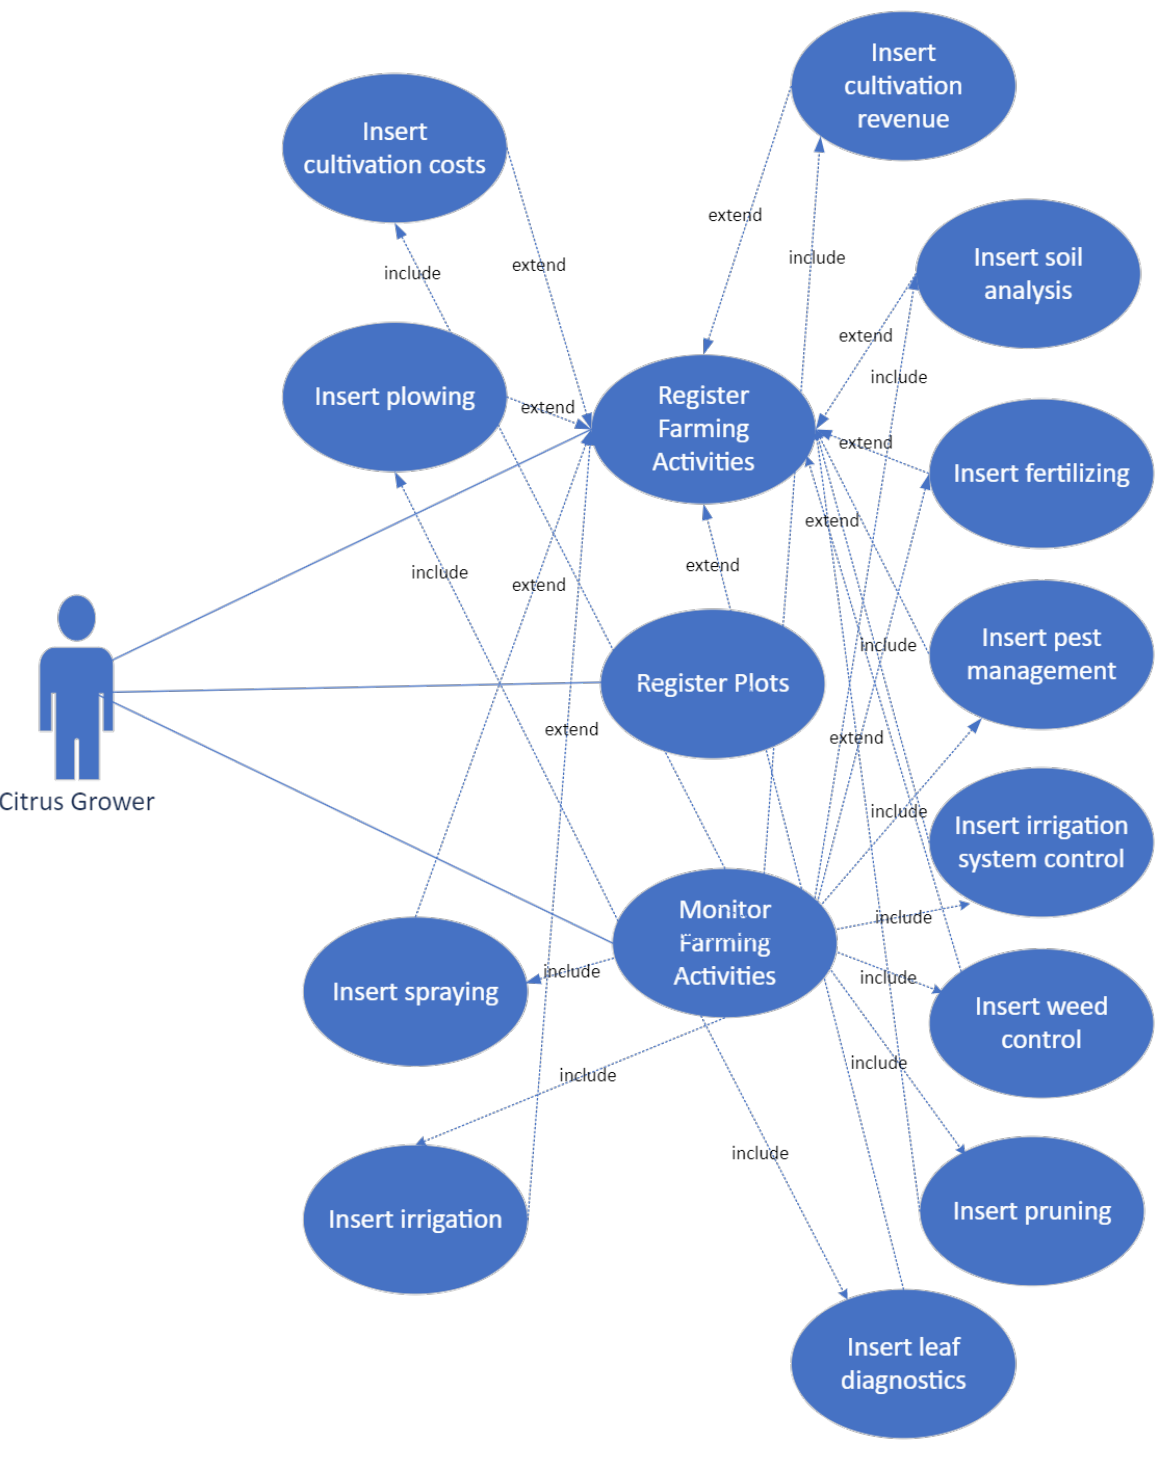
Figure 3. Use case diagram for the Agrendar app.